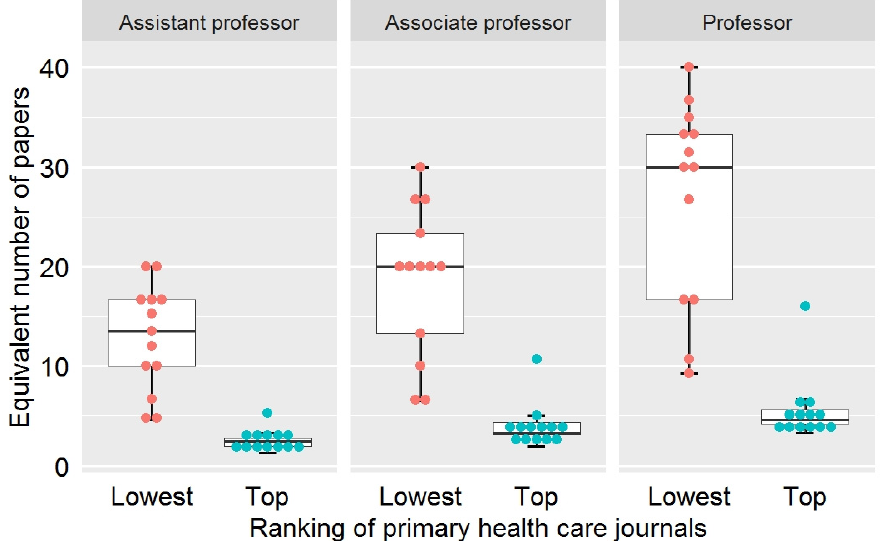
Figure 1. The distribution of the numbers of papers equivalent to different promotion thresholds using the impact factor of the top-ranked journal or that of the lowest-ranked journal in primary health care as a weight.